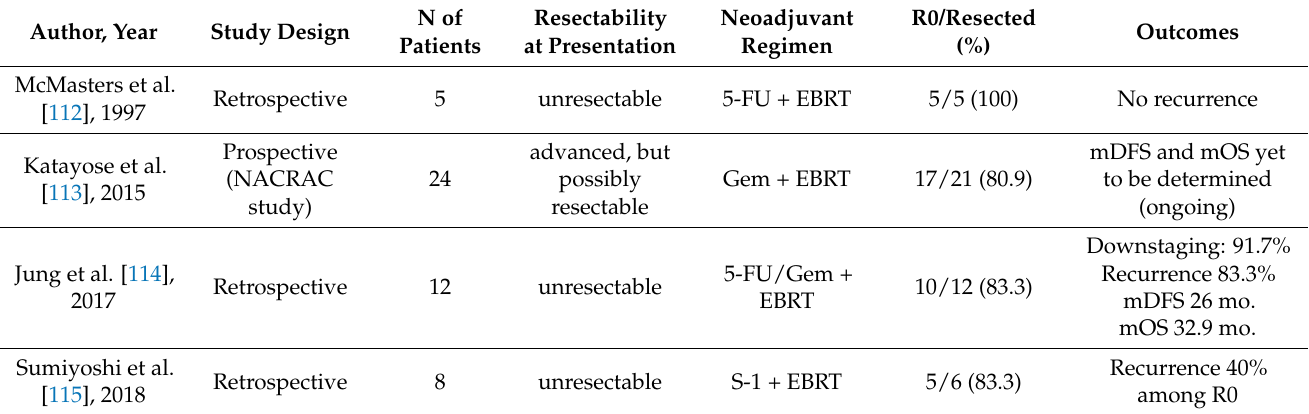
Table 3. Main studies assessing neoadjuvant chemoradiotherapy in